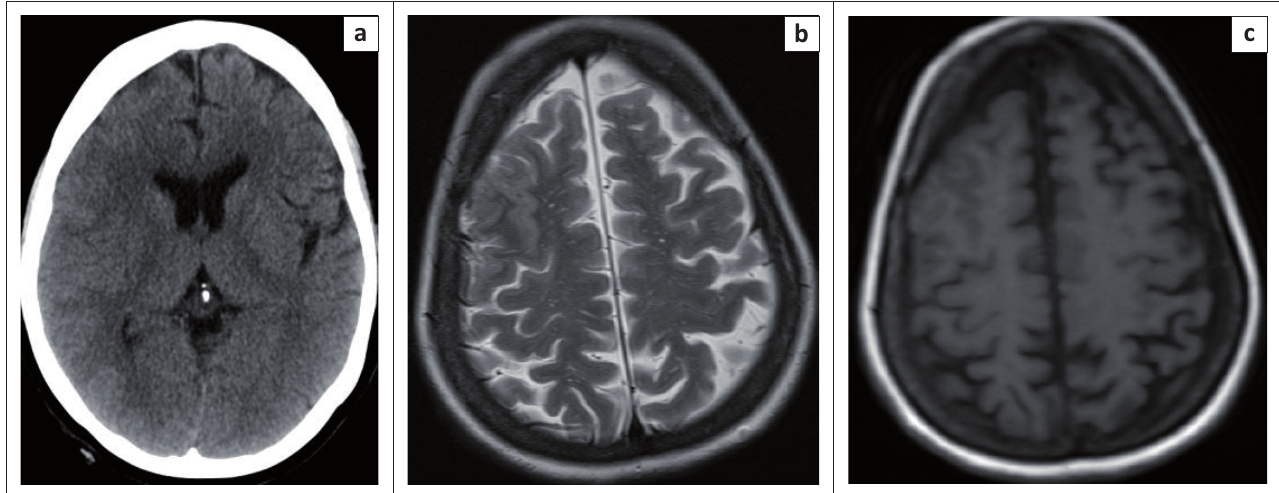
FIGURE 3: Axial non-contrasted (a) CT image, (b) T2 and (c) axial T1-weighted MRI images.